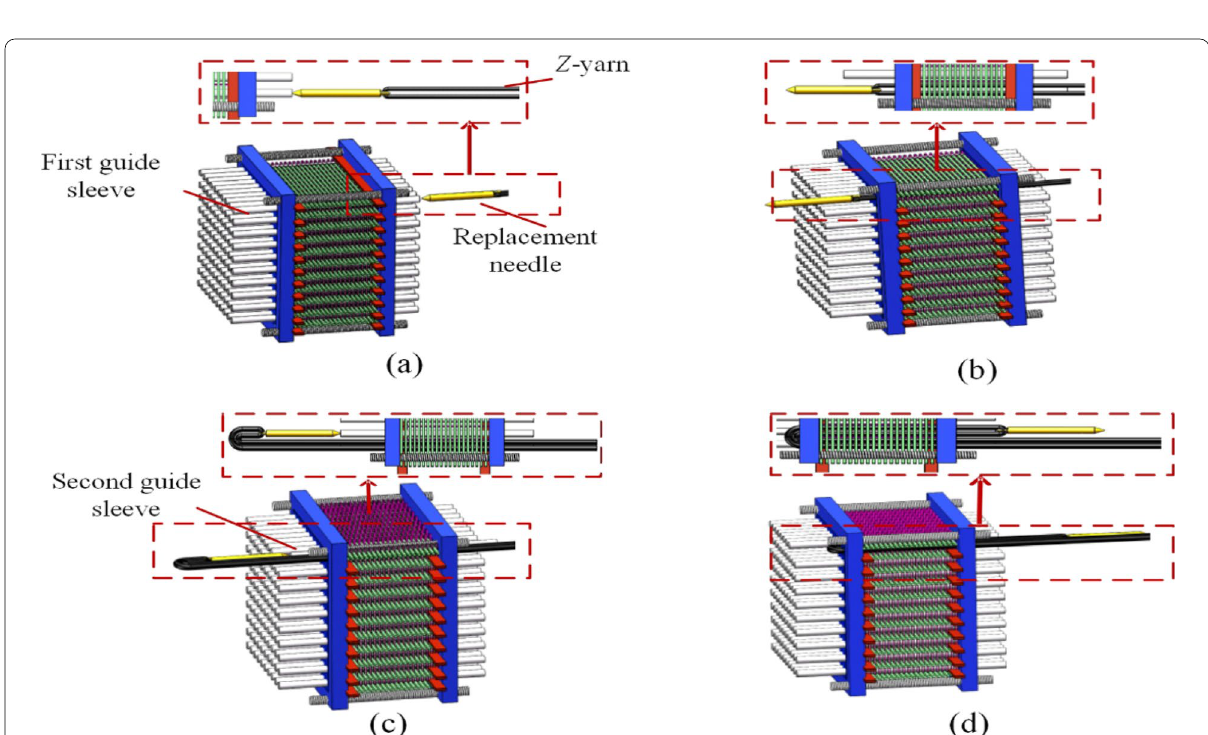
Figure 3 Z -yarn replacement guide